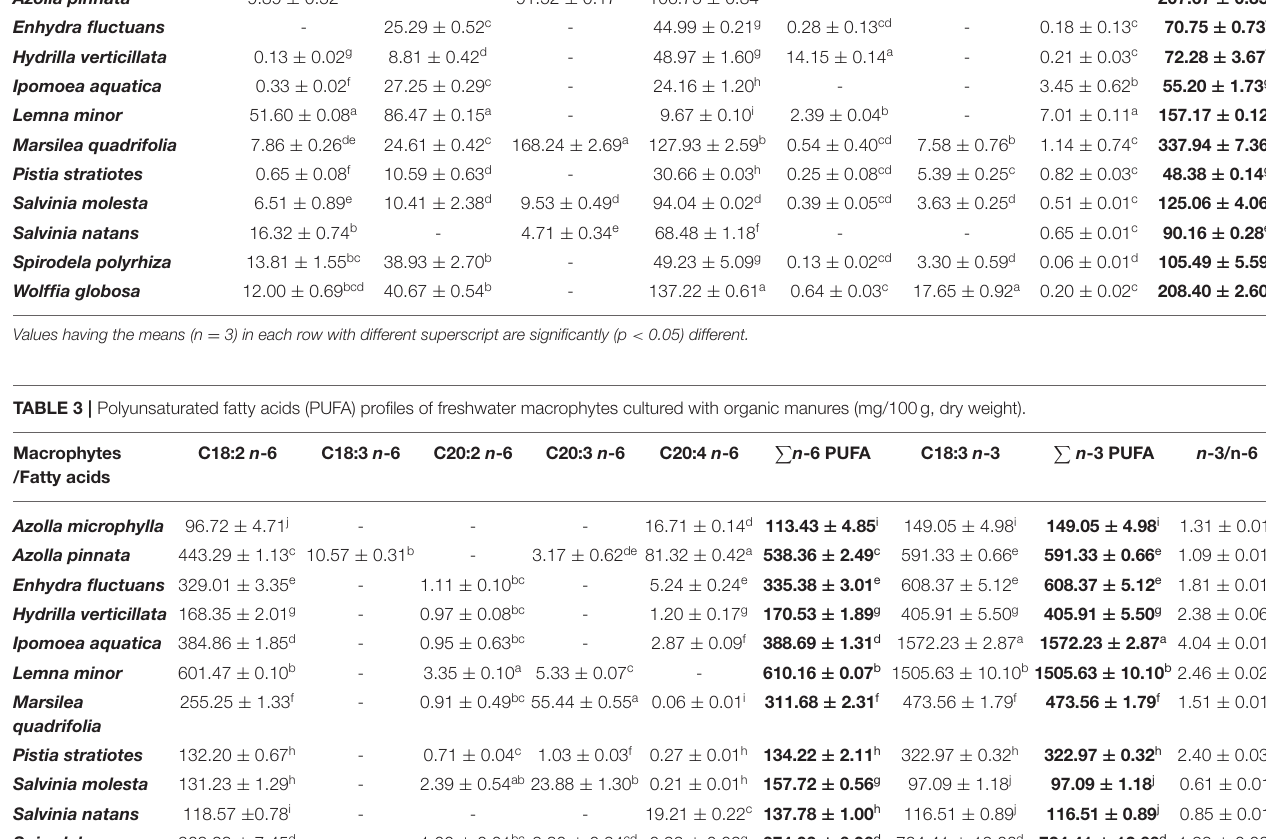
TABLE 2 | Monounsaturated fatty acids (MUFA) profiles of freshwater macrophytes cultured with organic manures (mg/100g, dry weight). Macrophytes /Fatty acids